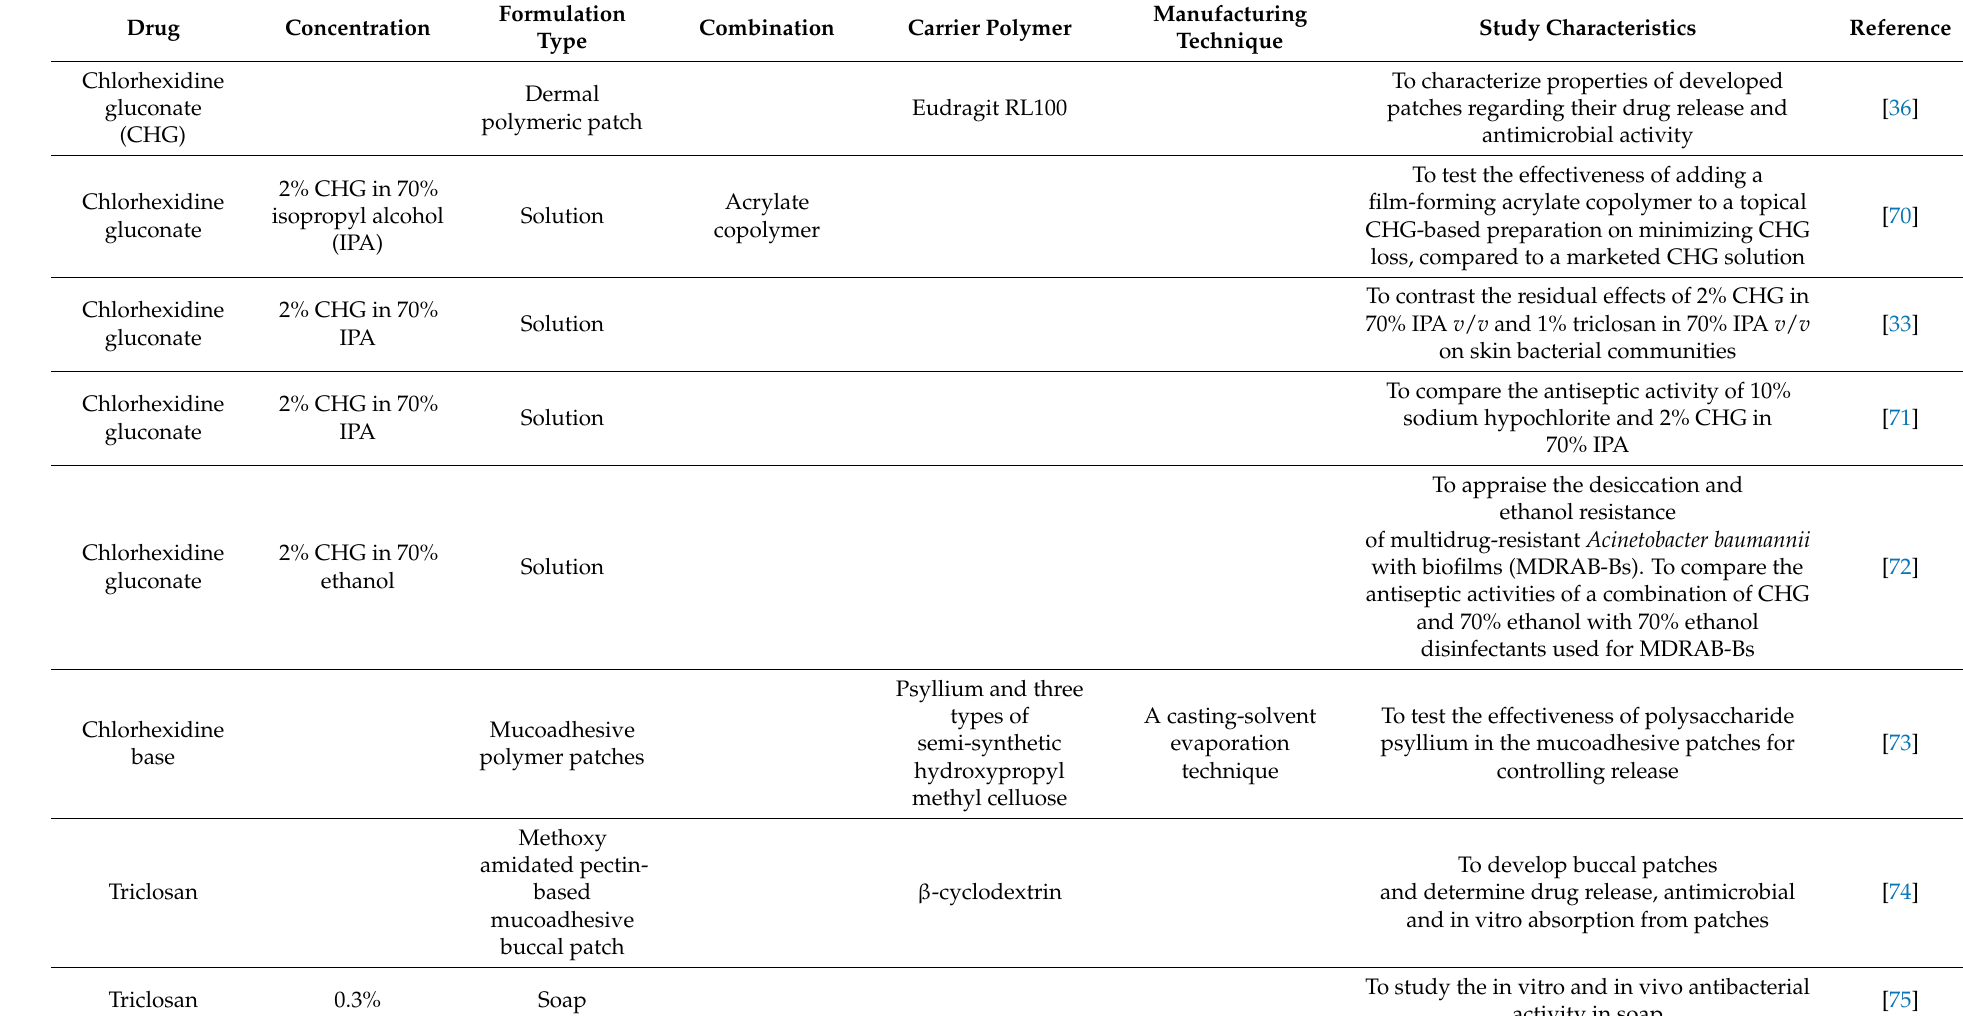
Table 1. Summarised characteristics of traditional skin antiseptic